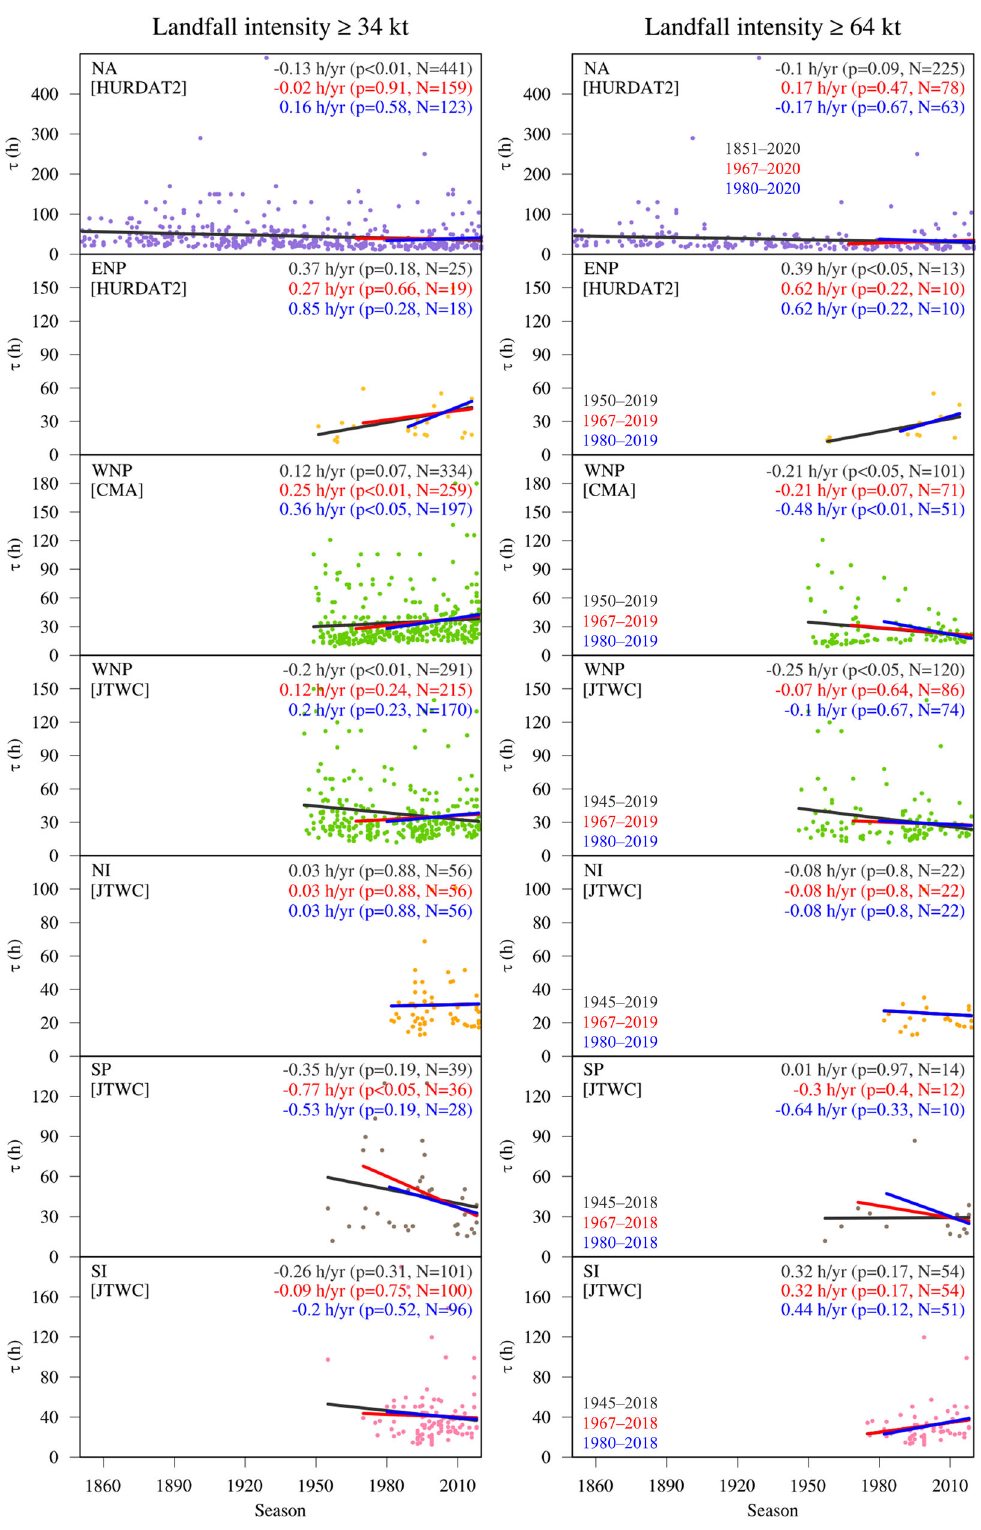
Fig. 2 Global climatology of the event-level decay of landfalling tropical cyclones. Left and right columns show the time series of the event-level τ (dots) and numbers of landfall events (bars) of tropical cyclones from individual basins with landfall intensity ≥ 34 kt and ≥ 64 kt, respectively (NA North Atlantic; WNP western North Paci fi c; NI North Indian Ocean; SP South Paci fi c; SI South Indian Ocean). Corresponding linear regression trends (lines), p values, and number of events N over different study periods are